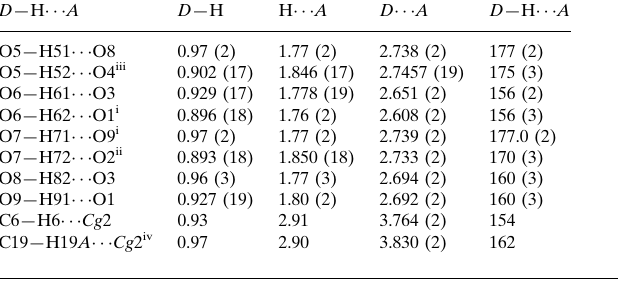
Hydrogen-bond geometry (A˚ , (cid:3)